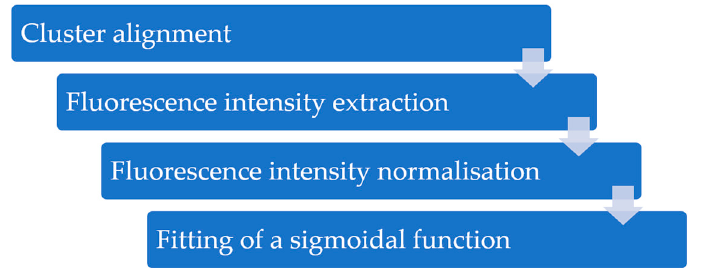
Figure 2. Overview of the image processing workflow. First, cluster centres obtained from sequencing were cross-correlated with the FLIP images, and the intensity from the registered fluorescent signals was extracted. Subsequently, the extracted fluorescence intensities were normalised, and the data aggregated across the images by cluster ID. Afterwards, a sigmoidal function was fitted to the aggregated data—the normalised fluorescence intensity, in dependence of target concentration—in order to obtain a binding curve and, hence, the K d for each cluster.